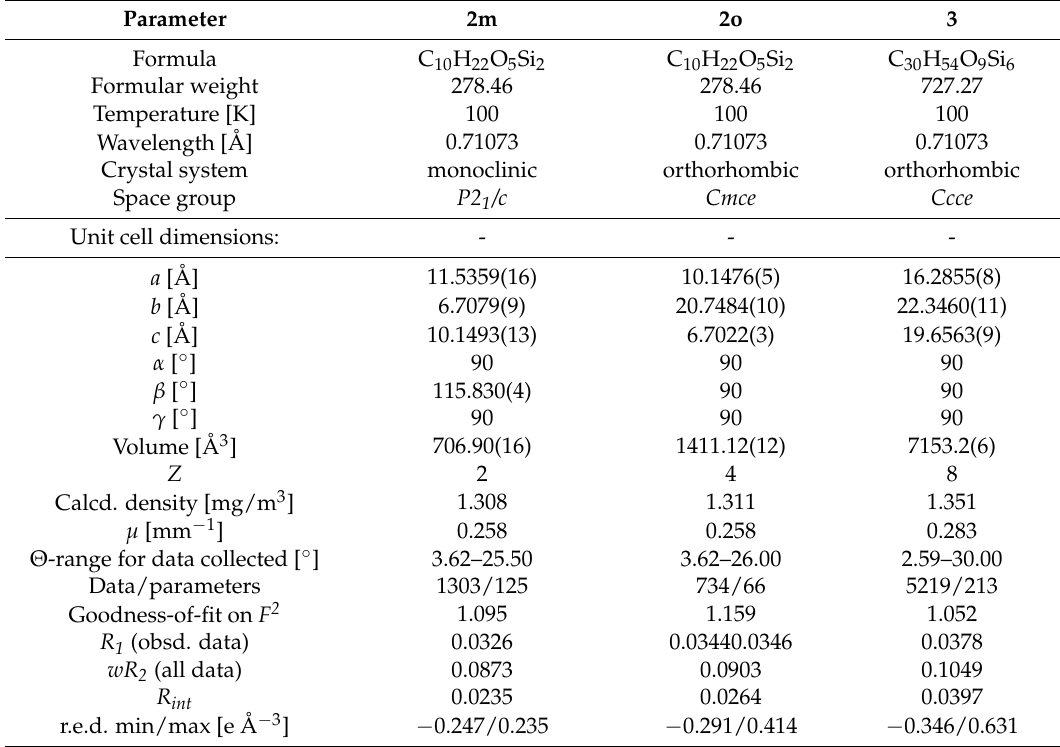
Table 1. Crystal data and structure refinement for 2 and 3